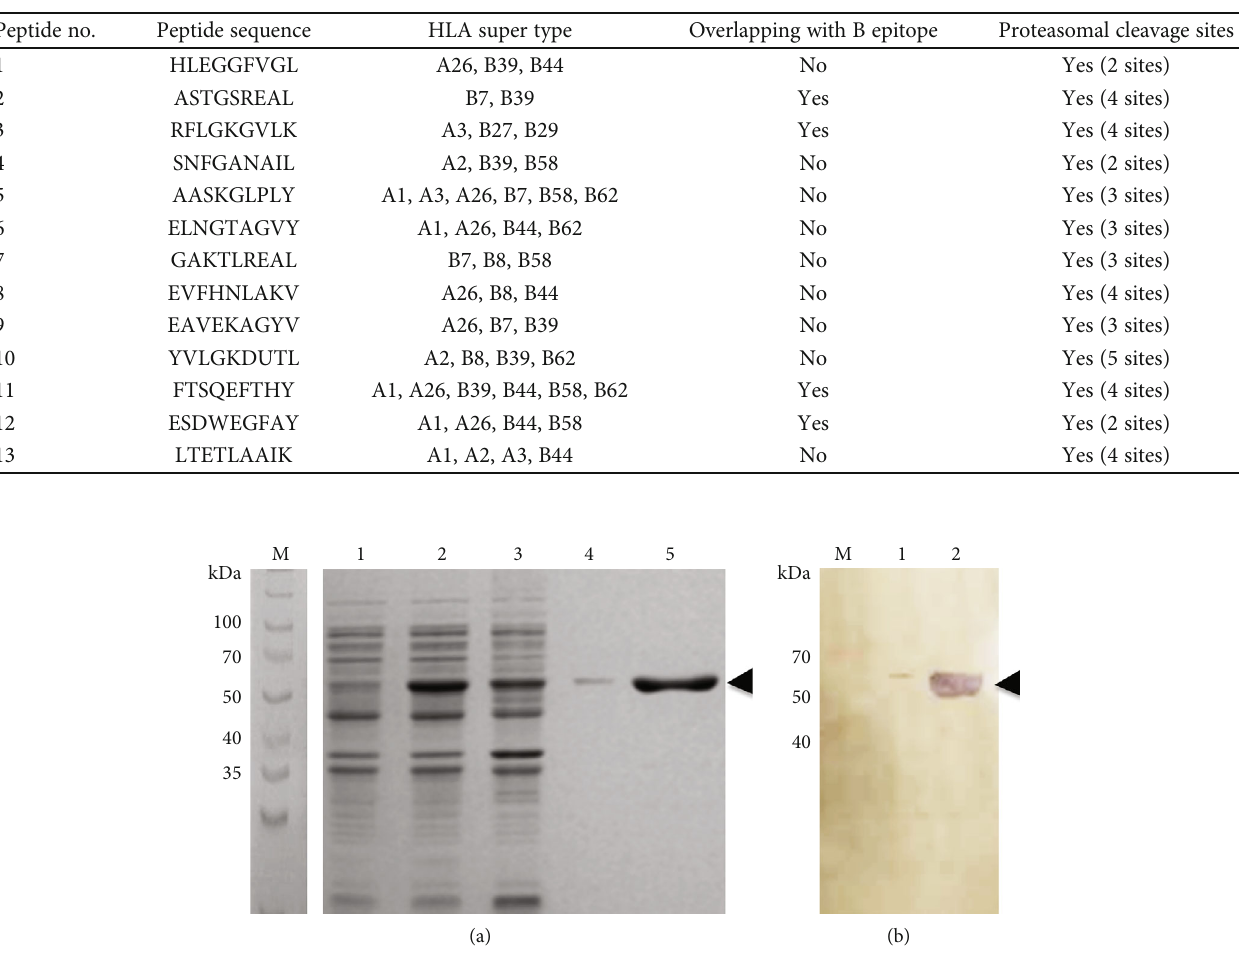
Figure 5: Puri fi cation and identi fi cation of rNTHiENO. Protein was resolved by SDS-PAGE on 12% polyacrylamide gel and stained with Coomassie blue. (a) Lane M: molecular weight marker. Lane 1: E. coli Bl21 cell containing the pRSET-A::NTHiENO without IPTG induction. Lane 2: E. coli Bl21 cell containing the pRSET-A::NTHiENO with IPTG induction. Lane 3: insoluble pellet. Lane 4: washing material. Lane 5: the puri fi ed rNTHiENO. Identi fi cation of rNTHiENO by western blot using a monoclonal antibody anti-His Tag. (b) Lane M: molecular weight marker. Lane 1: pRSET-A::NTHiENO in E. coli BL21, noninduced. Lane 2: puri fi ed rNTHiENO. The band corresponding to rNTHiENO (52.0 kDa) is indicated with an